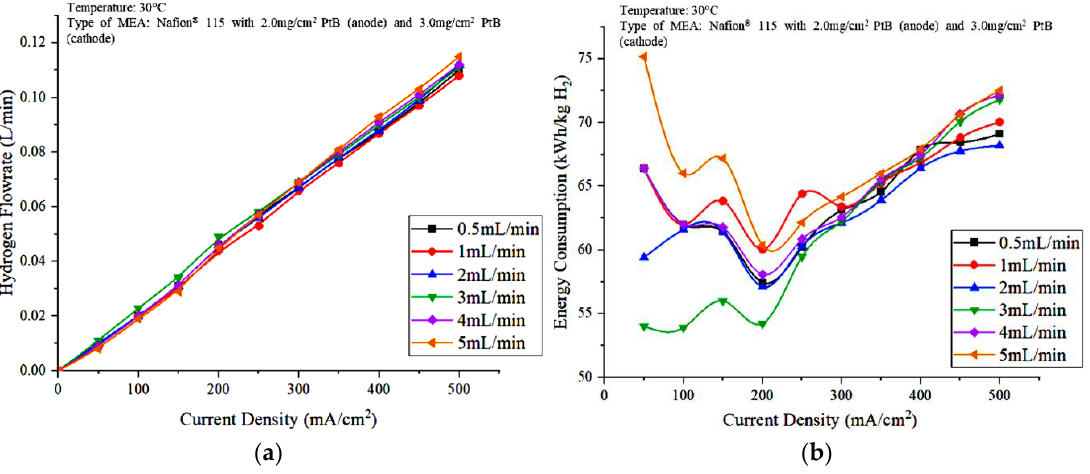
Figure 5. Effects of water flowrate on the ( a ) hydrogen production and ( b ) energy consumption of the PEM electrolyzer.